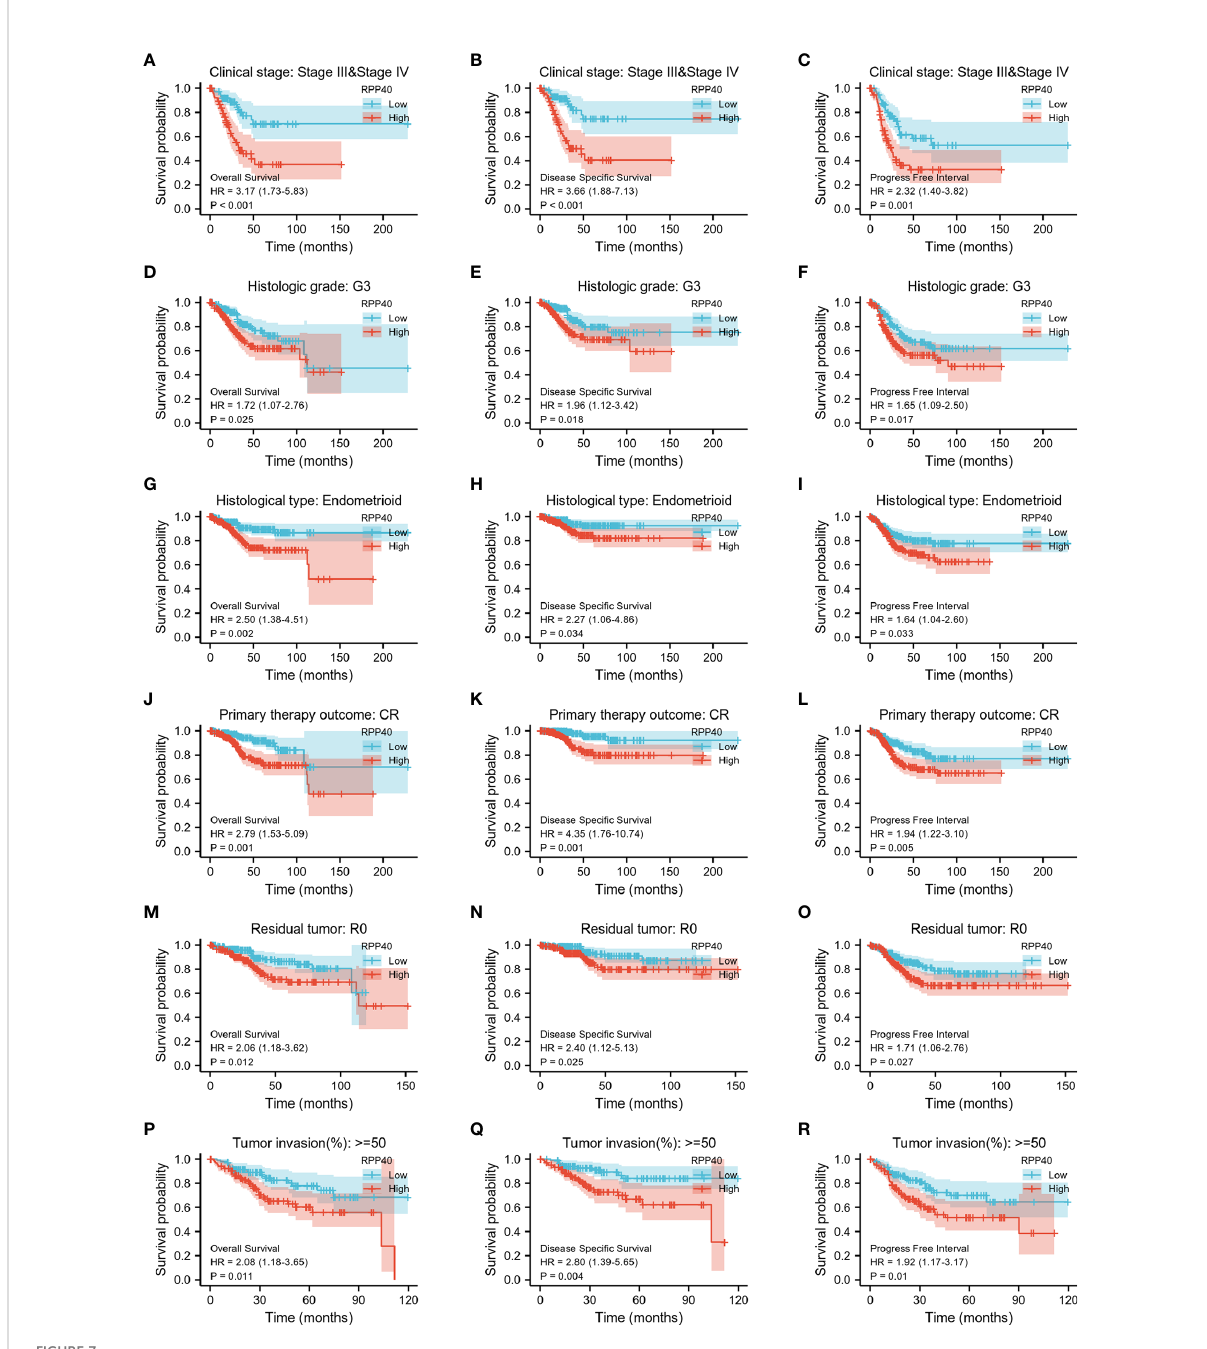
FIGURE 7 The association of clinical outcomes with RPP40 expression in UCEC patient form different subgroups based on clinicopathological factors. The result of K-M analysis showing distinct clinical outcomes of OS (A, D, G, J, M, P) , DSS (B, E, H, K, N, Q) , and PFI (C, F, I, L, O, R) between high- and low-RPP40-expression groups of UCEC patients in several subgroups, including clinical stage III – IV (A-C) , histological grade G3 (D-F) , the histological type of endometrioid (G-I) , the primary therapy outcome of CR (J-L) , residual tumor R0 (M-O) , and tumor invasion more than 50% of the muscular layer (P-R)